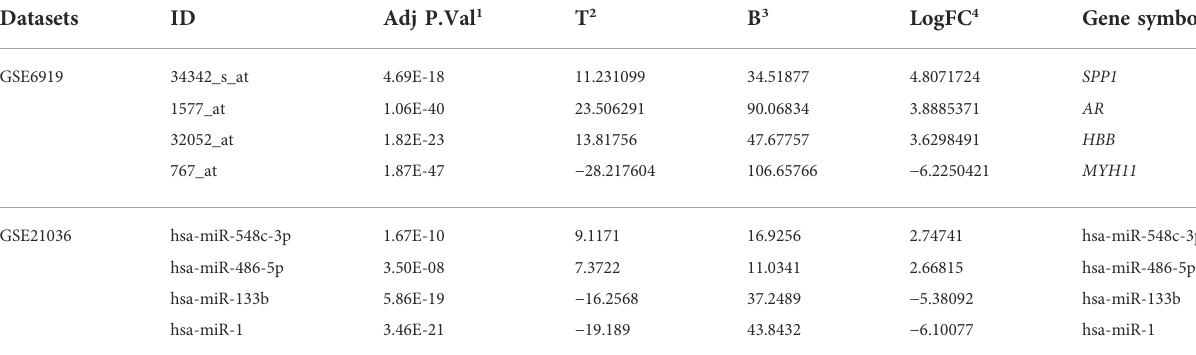
TABLE 1 The top four differentially expressed target genes and miRNAs.